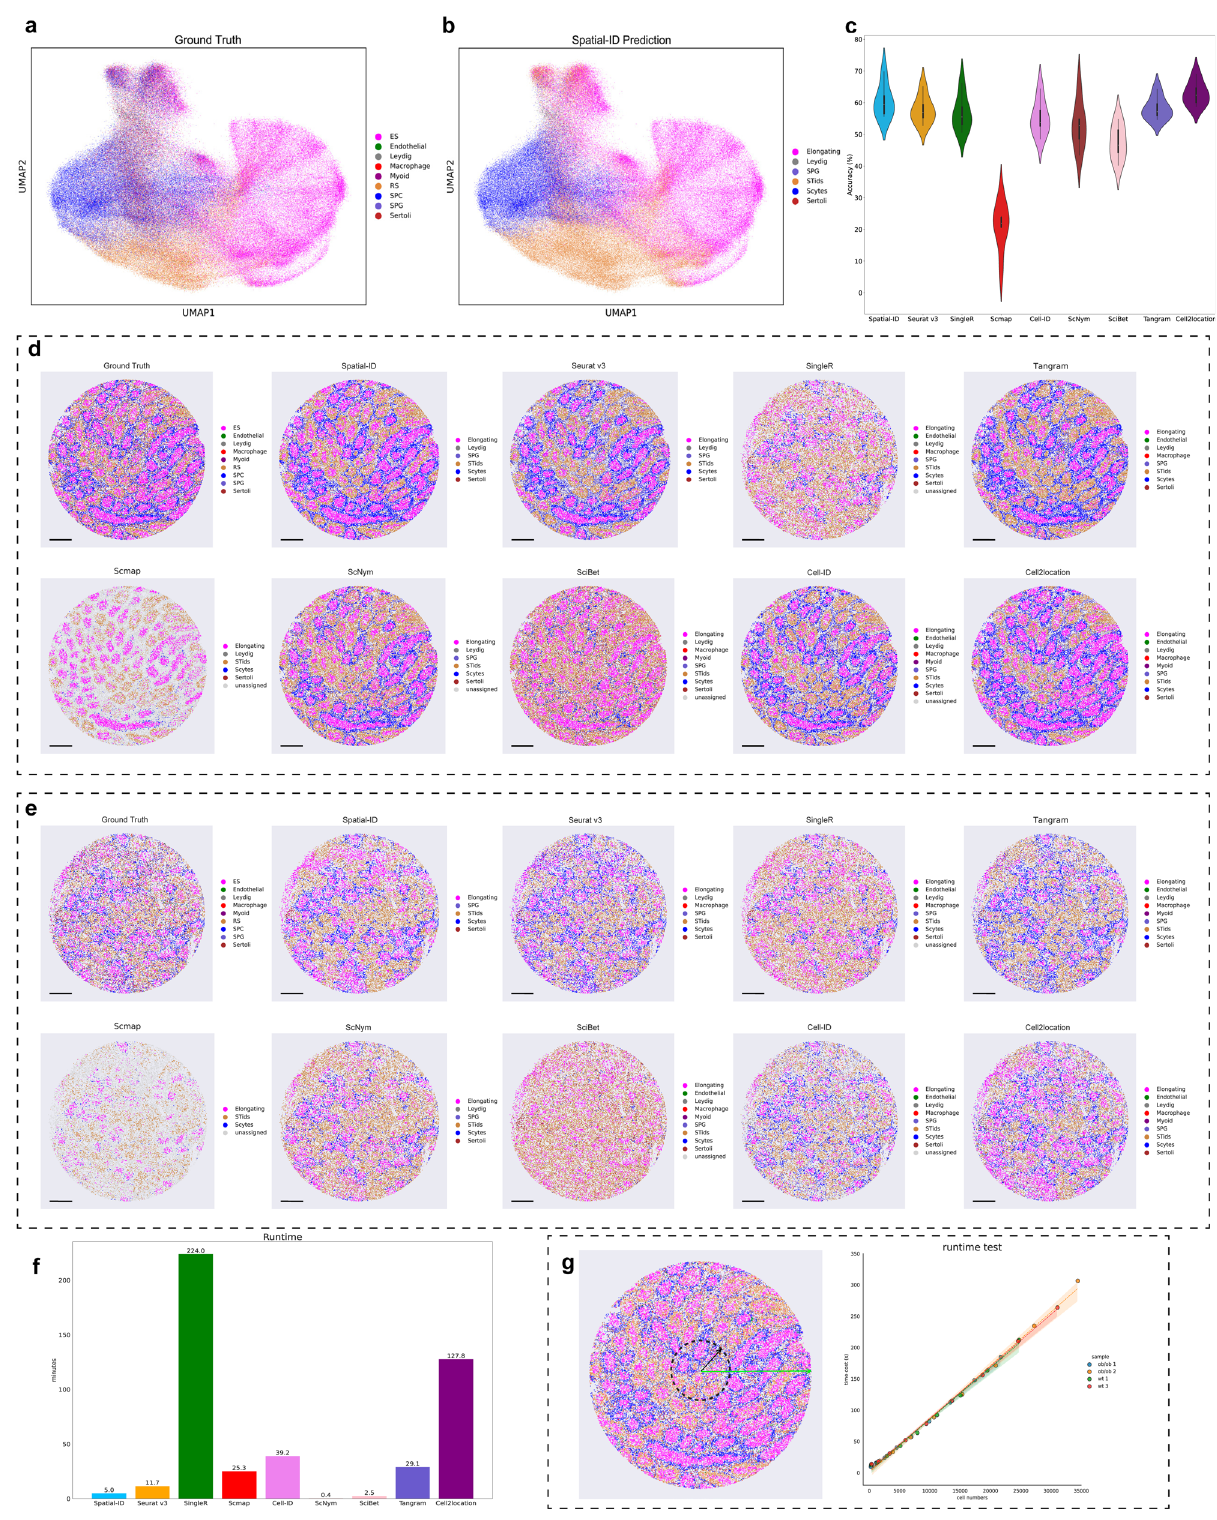
Fig. 4 | Application to mouse spermatogenesis dataset measured by Slide-seq. a Visualization of the ground truth cell types using UMAP embedding. ES elon- gating spermatid, RS round spermatid, SPC spermatocyte, SPG spermatogonium. b Visualization of the Spatial-ID predictions using UMAP embedding. c The com- parison of cell type annotation accuracy; n =6 independent samples; Center line, median; box limits, upper and lower quartiles; whiskers, 1.5× interquartile range. d Spatialorganization of the ground truth cell types ofa wild-type sample, and the predictions of Spatial-ID and the control methods. Bar scale 400 µ m. e Spatial